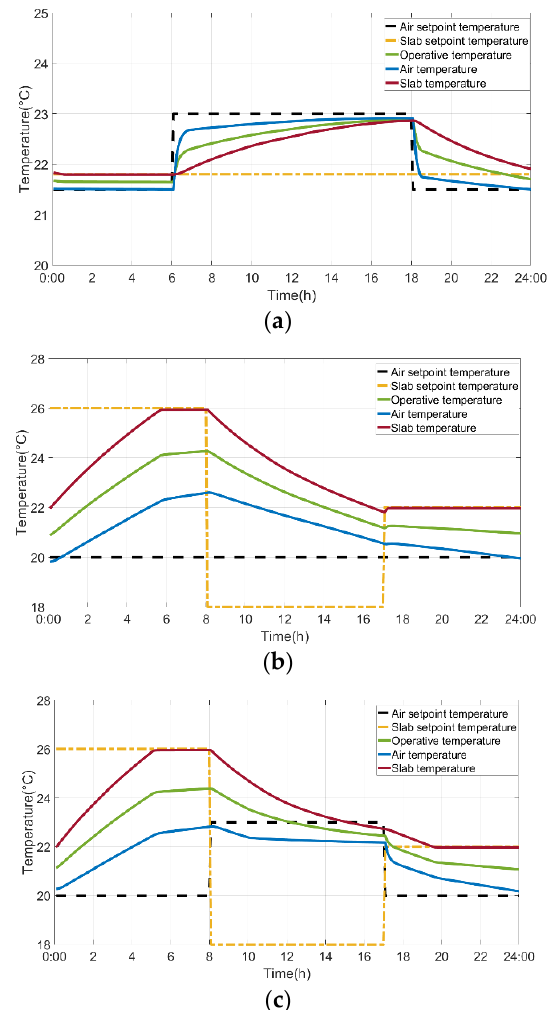
Figure 15. Temperature profile in different control strategies: ( a ) Control Strategy 1 (reference case); ( b ) Control Strategy 2; ( c ) Control Strategy 3.